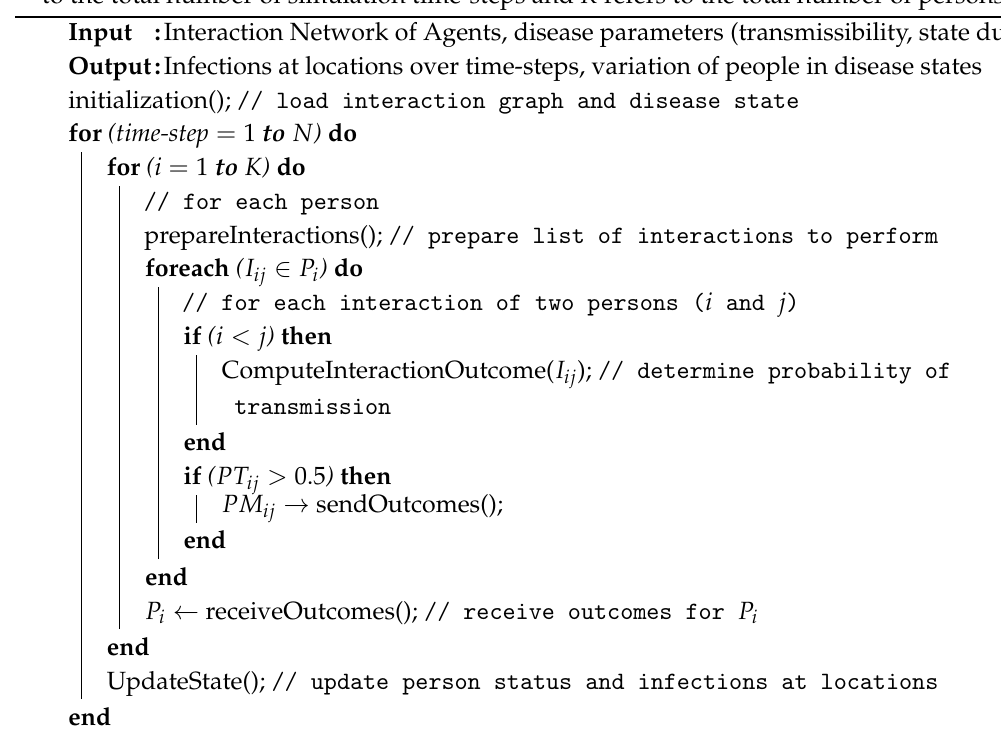
Algorithm 1: The general SIM-D algorithm, where P represents a Person, I ij refers to an interaction between Person i and j and PT ij refers to the outcome of their interaction. N refers to the total number of simulation time-steps and K refers to the total number of persons. Input : Interaction Network of Agents, disease parameters (transmissibility, state duration) Output: Infections at locations over time-steps, variation of people in disease